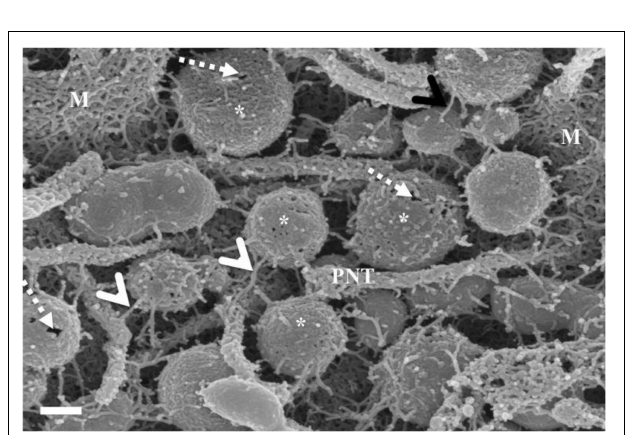
FIGURE 2 | The HRSEM micrograph depicts nanovesicular structures emanating from the b.End5 cell (Scale bar = 200 nm). This category of EV is porous in nature enabling them to act as generators of a chemotaxic gradient and also protrude sticky filaments (white arrowheads), further enabling it to be anchored close to their area of formation. These EVs range from 30 to 300 nm in size and thus are categorized as nanovesicles. The “perforated white arrows” indicate the pores of the exosomes. “ M ” denotes the plasmalemma outer surface, the * asterisk denotes the nanovesicle (NV) and “ PNT ” denotes primordial